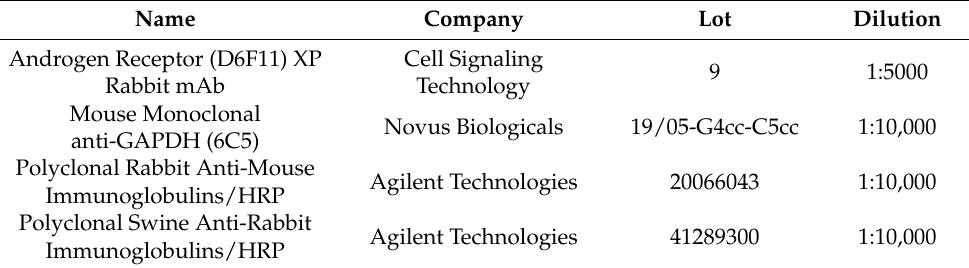
Table 2. Antibodies used in the